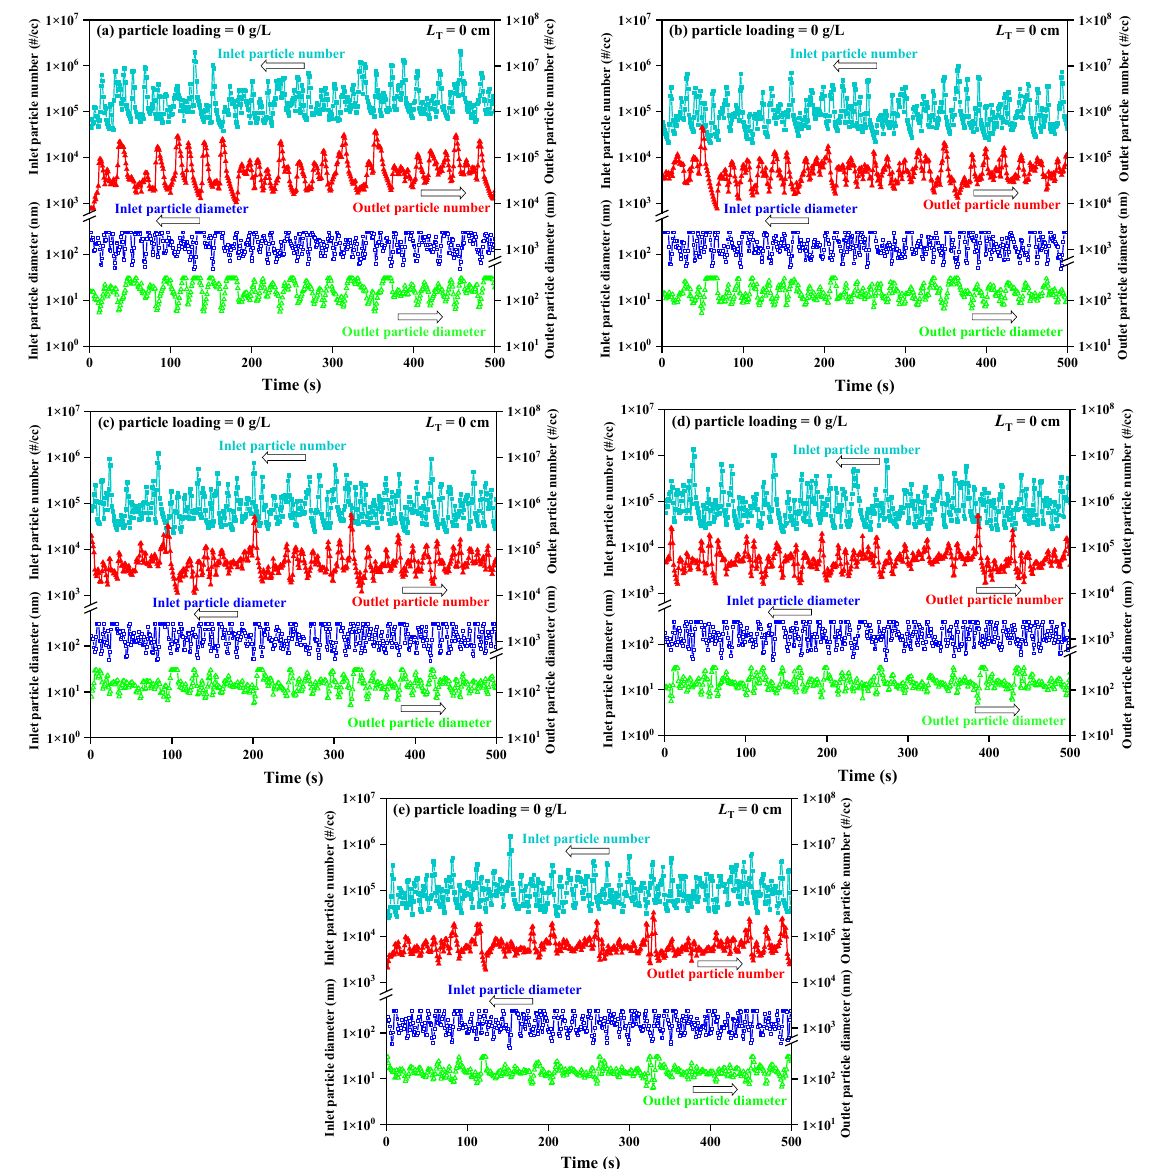
Figure 4. Particle concentration and particle size distribution of DPF inlet and outlet in steady filtration experiment with particle loading of 0 g/L, transition section length L T of 0 cm under different filtration temperatures: ( a ) 25 °C; ( b ) 100 °C; ( c ) 200 °C; ( d ) 300 °C; ( e ) 400 °C.